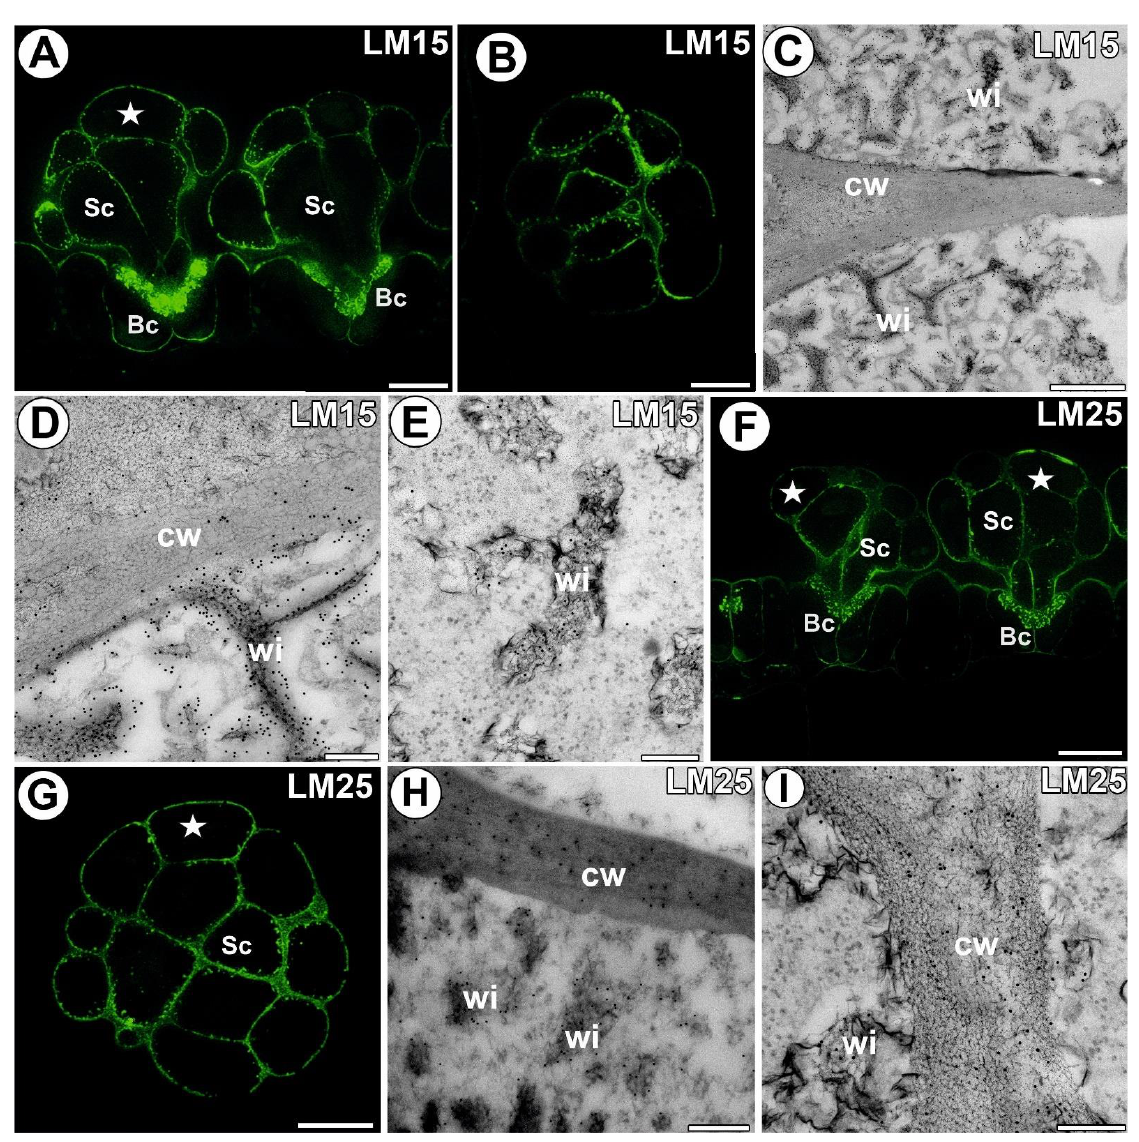
Figure 5. Xyloglucan detected in the A. vesiculosa trap. ( A ) Xyloglucan (labeled with LM15) de- tected in the glands; secretory cell (star), stalk cell (Sc), basal cell (Bc), bar 10 µm. ( B ) Xyloglucan (labeled with LM15) detected in the gland, transverse section; bar 10 µm. ( C-D ) Immunogold la- beling of wall ingrowths with LM15 in the basal cells; wall ingrowths (wi), cell wall (cw); bar 800 and 200 nm, respectively. ( E ) Immunogold labeling of wall ingrowths with LM15 in the glandular cells; wall ingrowths (wi), cell wall (cw); bar 200 nm. ( F ) Xyloglucan (labeled with LM25) detected in the glands and trap wall; secretory cell (star), stalk cell (Sc), basal cell (Bc), bar 10 µm ( G ) Xy- loglucan (labeled with LM25) detected in the gland, transverse section; secretory cell (star), stalk cell (Sc), bar 10 µm. ( H-I ) Immunogold labeling of wall ingrowths with LM15 in the gland cells; wall ingrowths (wi), cell wall (cw); bar 300 nm and bar 200 nm.